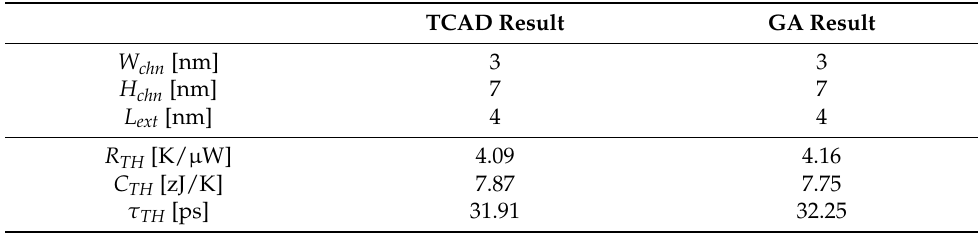
Table 4. Comparison of TCAD and GA